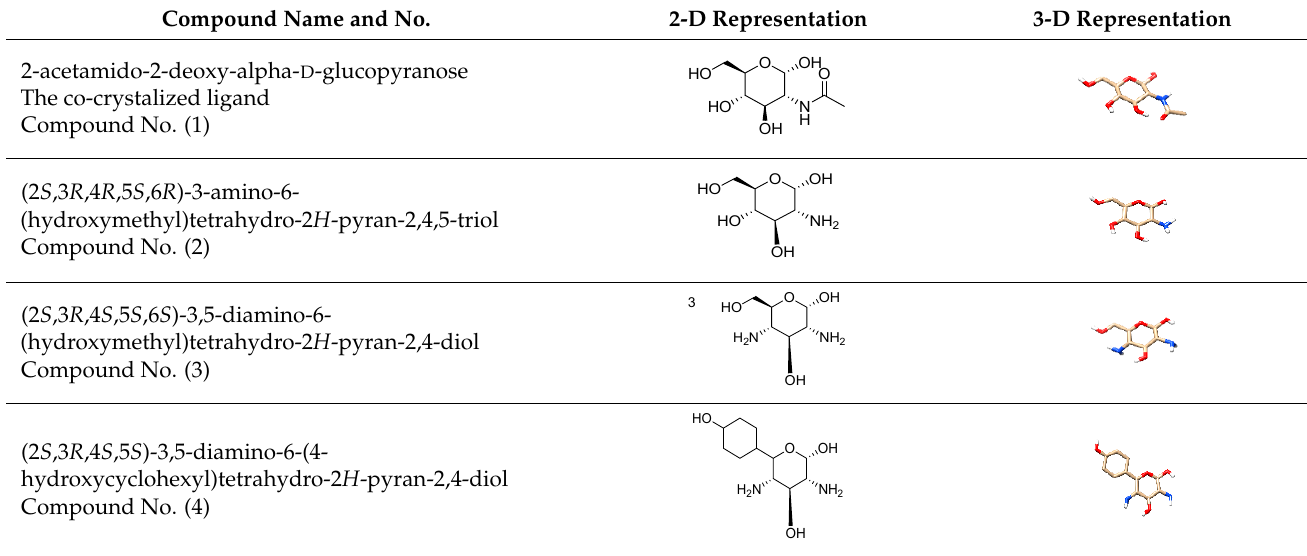
Table 5. Two-dimensional and three-dimensional optimized energy-minimized structures of the possible compounds released by using the ChemDraw and Moe programs. Compound Name and No.